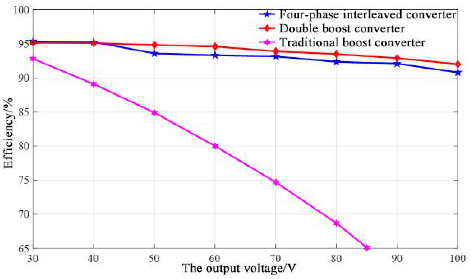
Figure 19. Efficiency comparison at different output voltages.